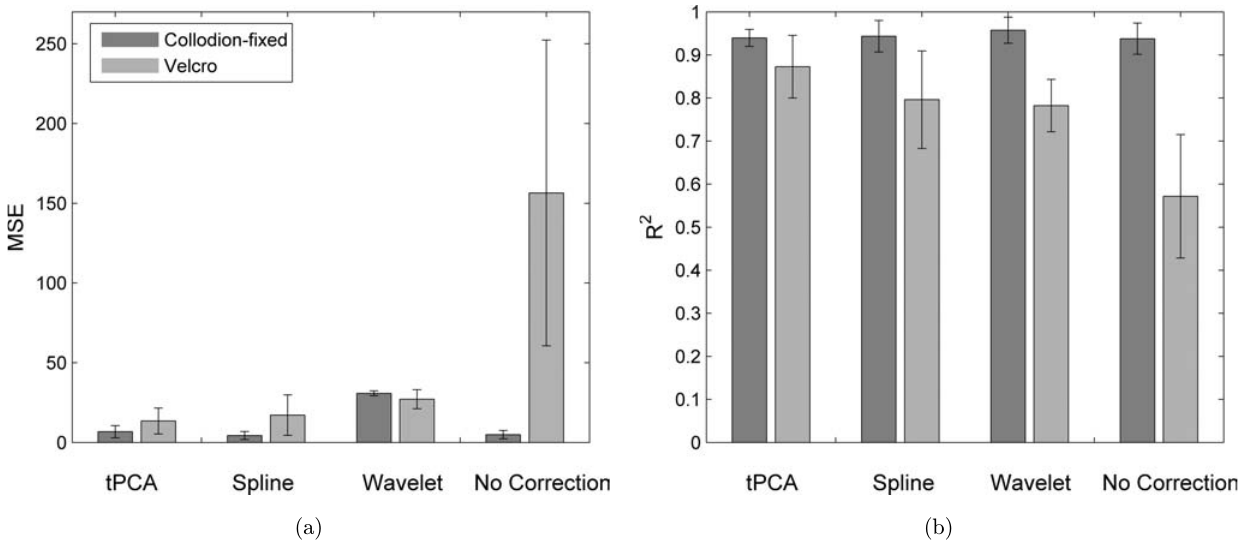
Fig. 4. The group mean and standard deviation for MSE (a) and Pearson's correlation coe±cient (b) obtained from the channels for the Collodion-¯xed ¯ber probe (green) and the Velcro-based probe (blue) corrected for motion artifacts by tPCA, spline interpolation, wavelet-based ¯ltering and compared against no